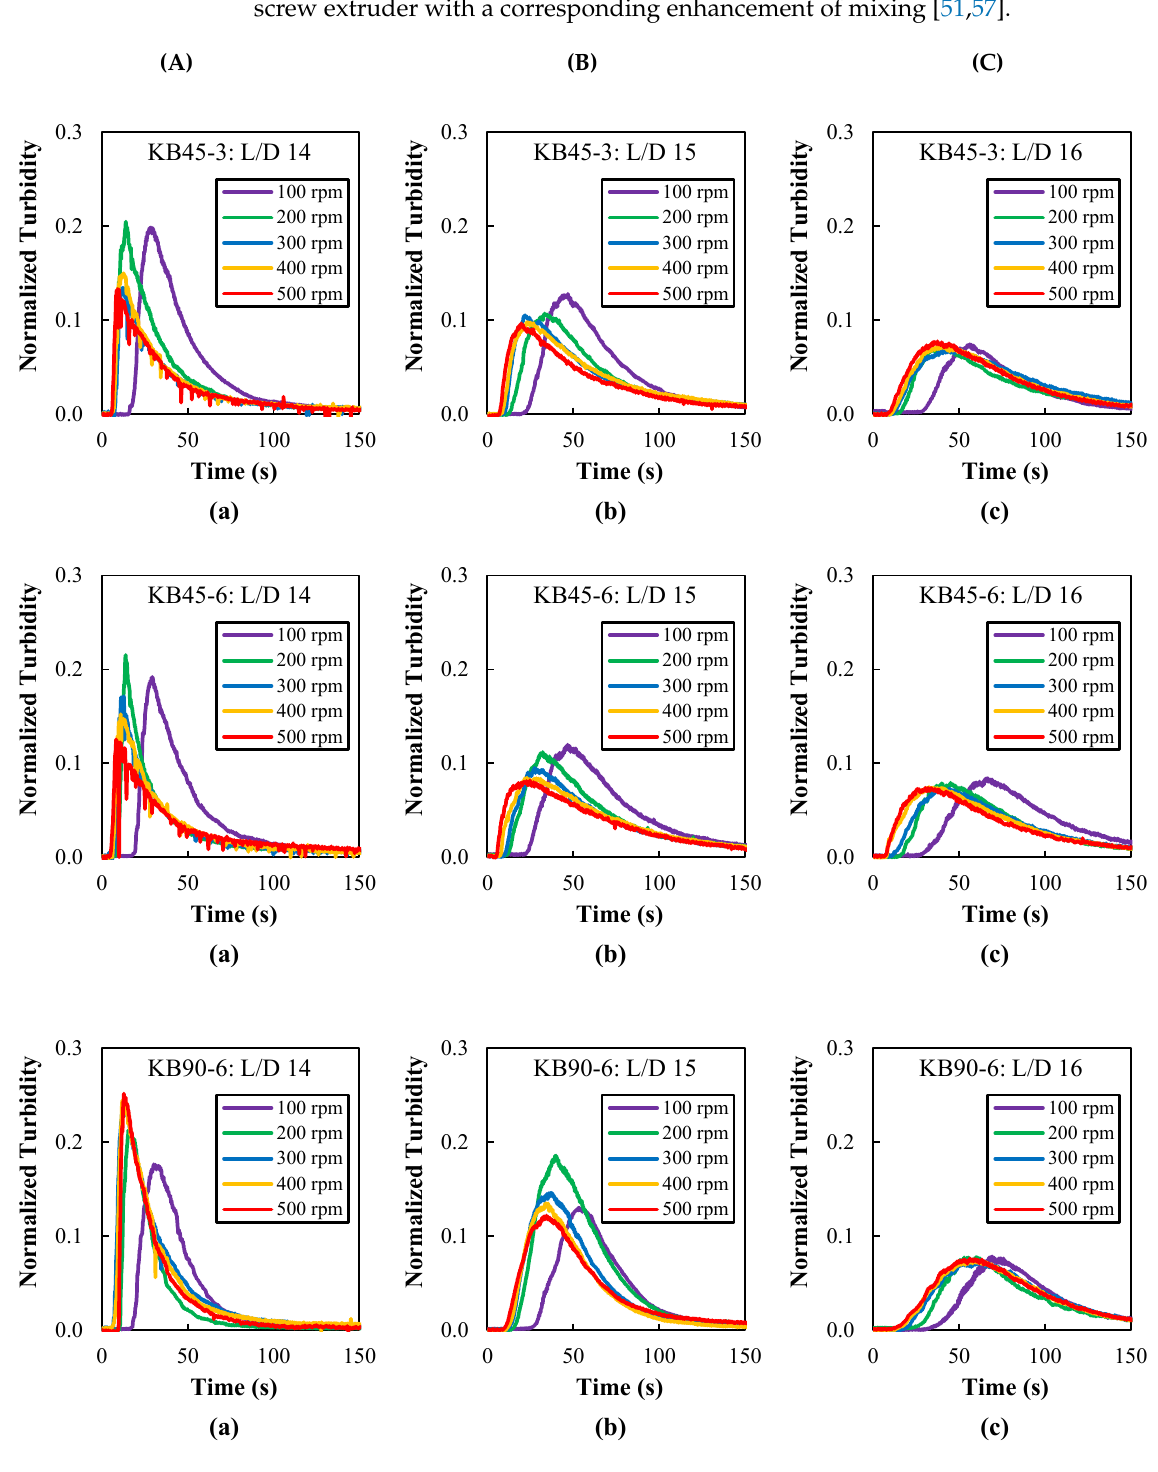
Figure 6. Residence time distribution (RTD) curves measured with the barrel set to 230 °C along the mixing zone at ports: ( a ) L/D = 14, ( b ) L/D = 15, and ( c ) L/D = 16 for different kneading blocks ( A : KB45-3, B : KB45-6, and C : KB90-6) as a function of screw speed (100 to 500 rpm). The time scale was shortened to 150 s to better show the major peak area.